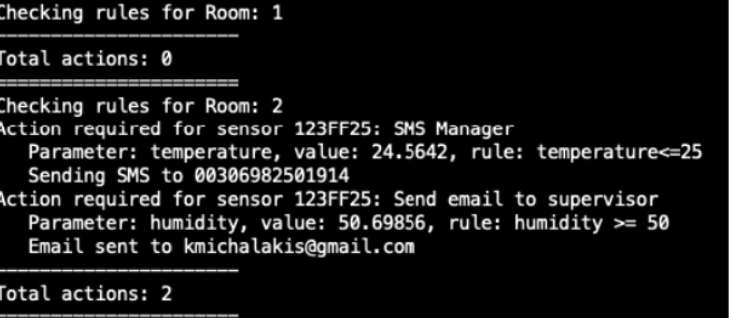
Figure 10. Screenshot of real time monitoring